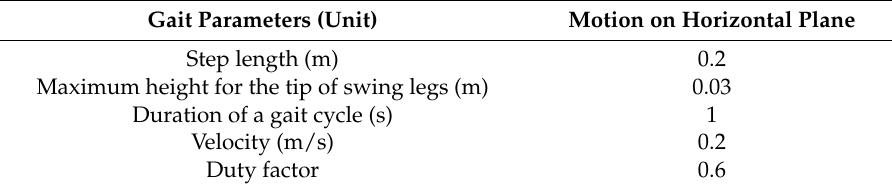
Table 3. Trot-gait